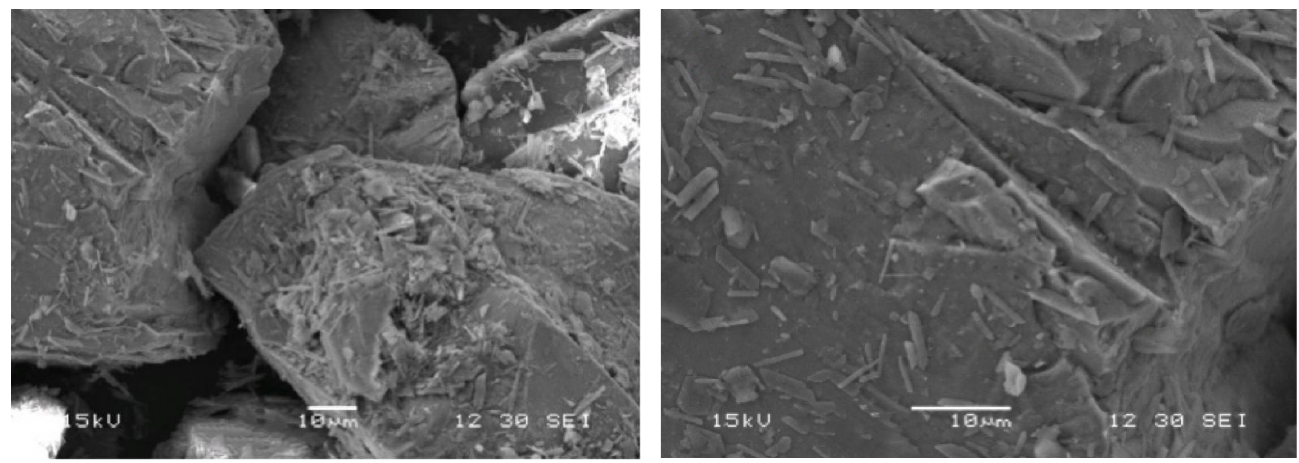
Figure 5. Powder particle scan results.